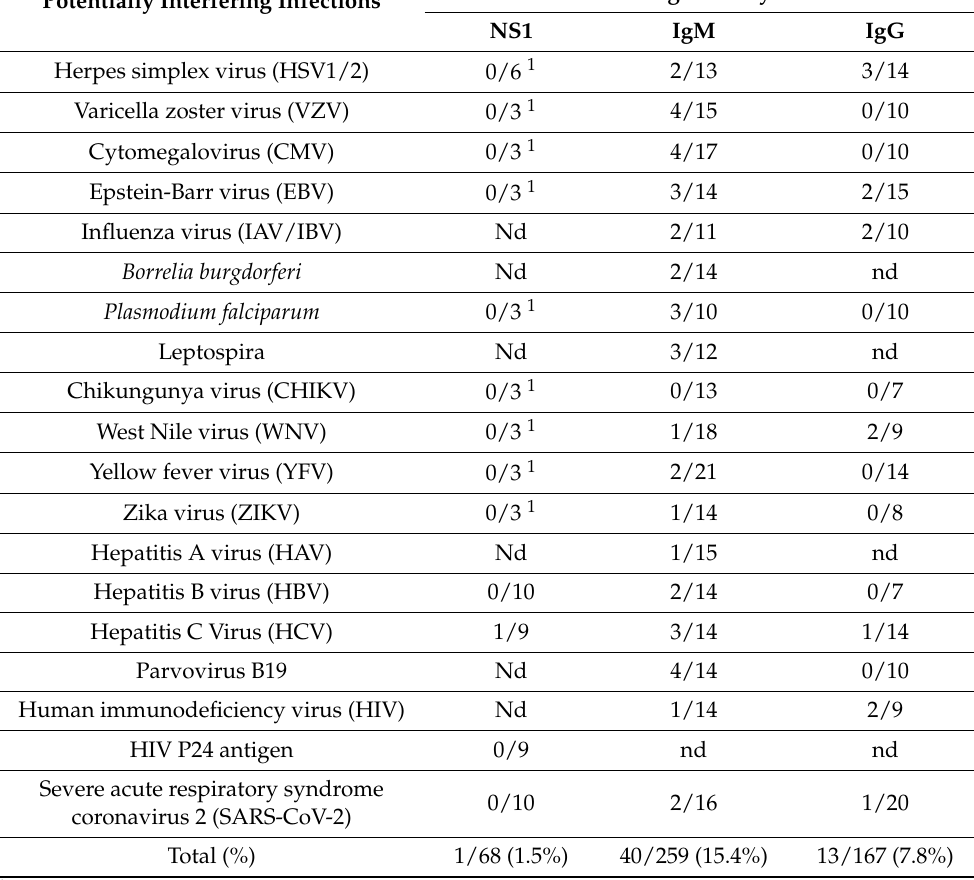
Table 6. Cross-reactivity with the VIDAS ® dengue NS1, IgM, and IgG assays using either contrived or native samples from patients with other potentially interfering infections (all samples tested negative by the respective competitor